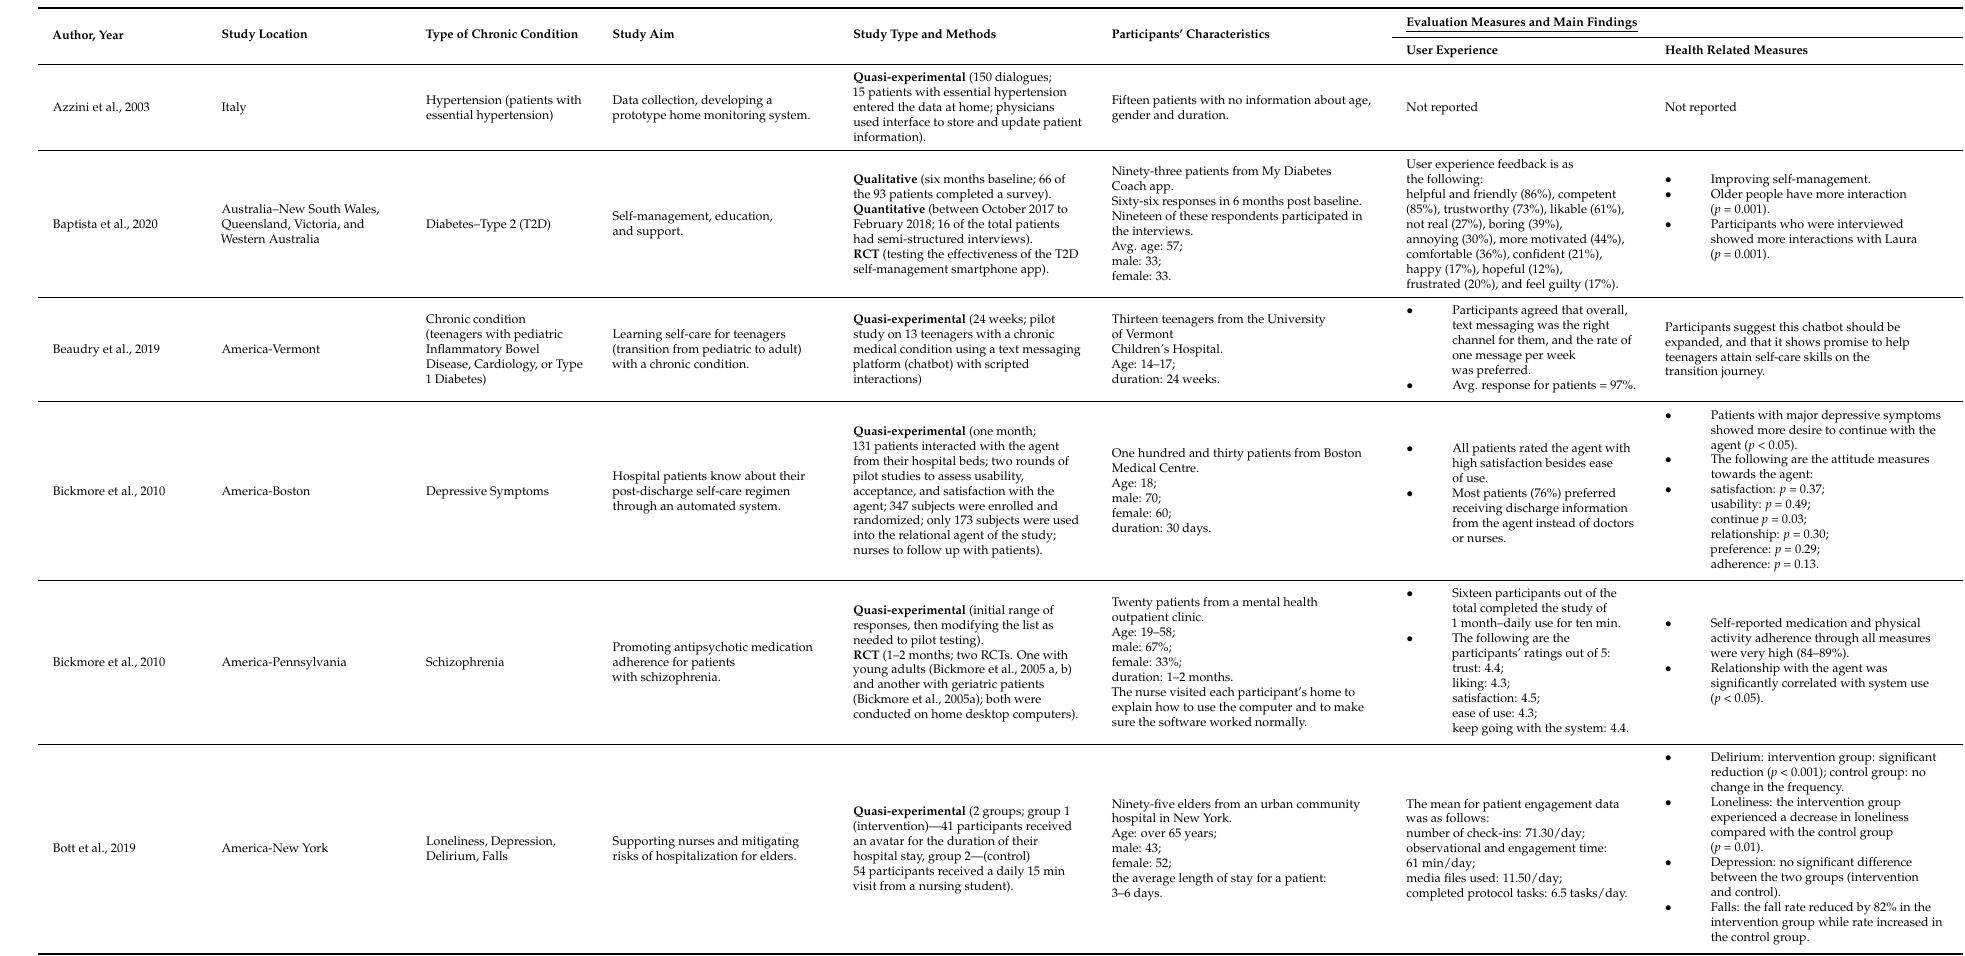
Table 1. Overview and characteristics of included